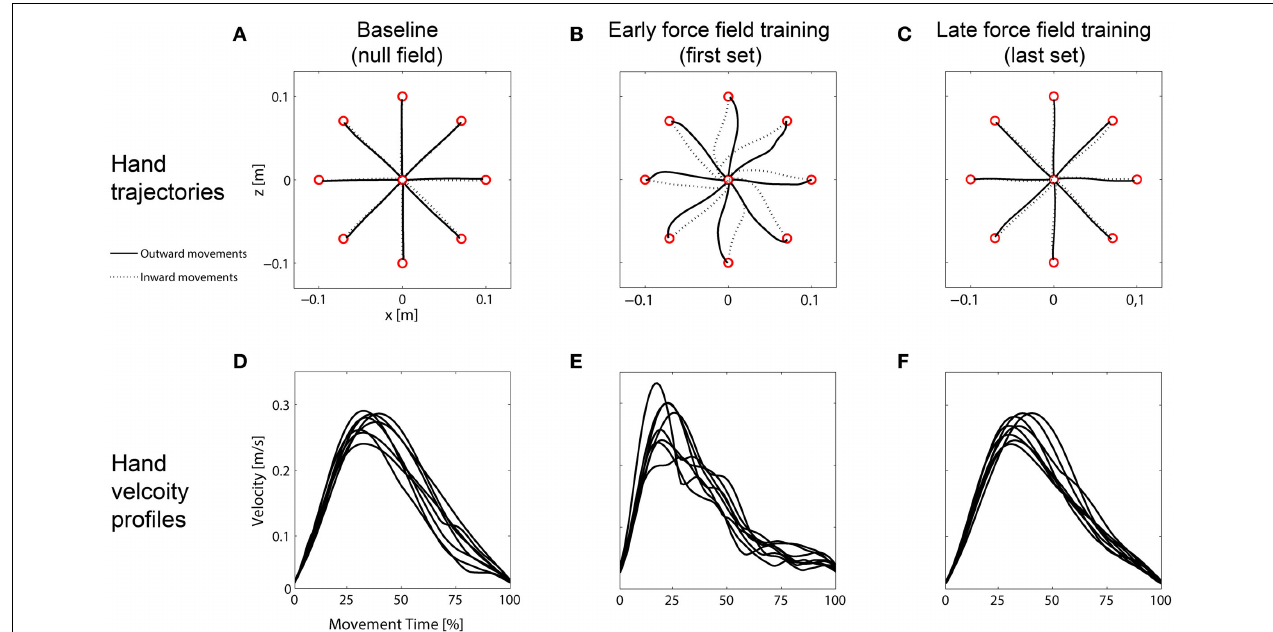
FIGURE 2 | Representative mean hand trajectories and mean hand velocity profiles (outward movements only) of one group. (A) Straight-lined baseline trajectories. (B) Disturbed trajectories at the beginning of force field adaptation (first set). (C) Reshaped straight-lined trajectories at